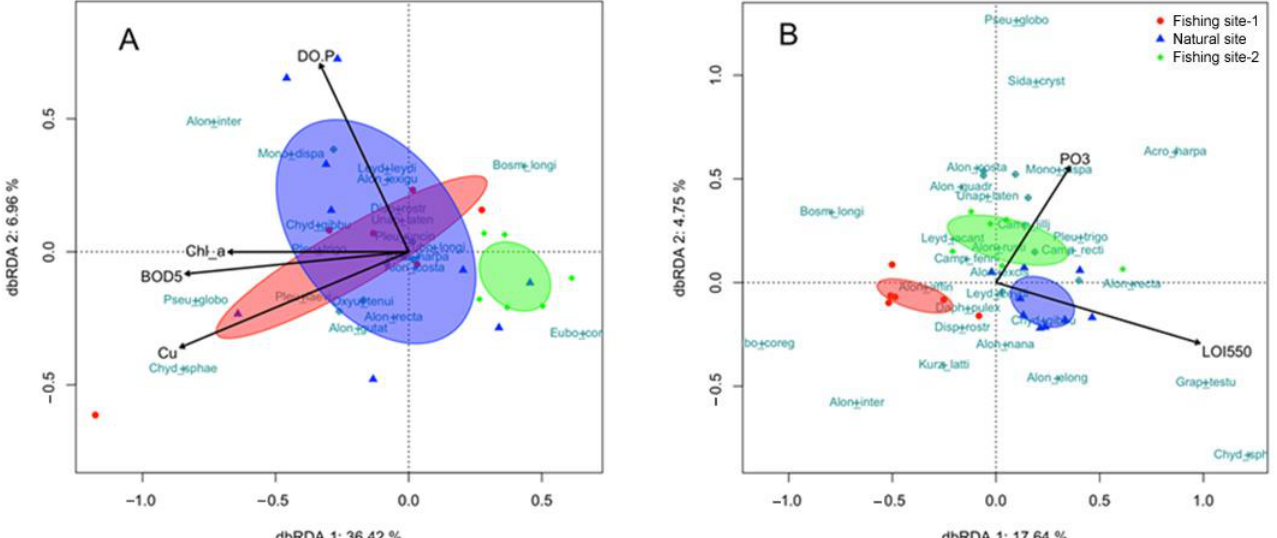
Distance-based redundancy analysis (dbRDA) ordination plot showing ( A ) contemporary and ( B ) subfossil Cladocera assemblages among the three sites concerning forward measured physical–chemical variables; Color of sites represented samples taken from the three different sites (Red color-Fishing site-1, Blue color-Natural site, and Green color-Fishing site − 2).